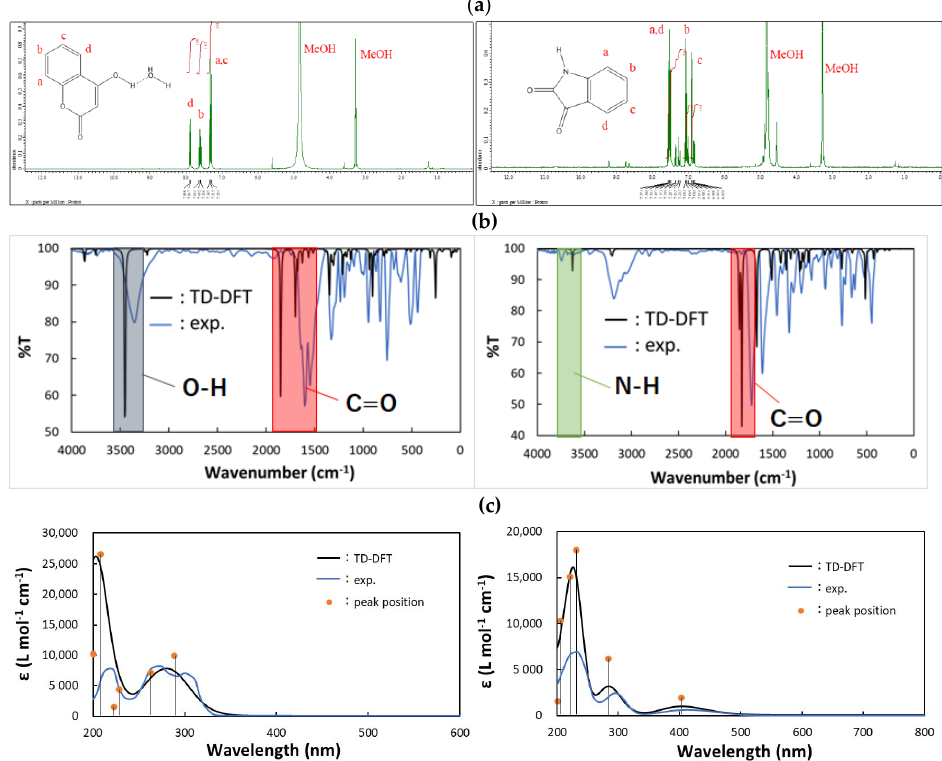
Figure 2. Comparison with experimental and DFT computational results of ( a ) NMR (only experimental) ( b ) IR and ( c ) UV-vis spectra for (left) CA1 and (right) CA4 . Both molecules adopted planar structures, with all the heavy atoms on one mean plane. As for CA1 , the six-membered carbon ring and heterocyclic moiety in the compound adopt a planar structure orientation, and are arranged in a parallel to slightly tilted position in the crystal. Significant hydrogen-bonding interactions of O1-H1A · · · O4 (O . . . O = 2.5578(13) Å), O4-H4A · · · O3 (cid:48) (O . . . O = 2.7659(15) Å), and O4-H4B · · · O3 (O . . . O = 2.7443(15) Å) are very much evident in the (Figure 3) (symmetry operation ‘: 1/2 − x, 1 − y, − 1/2 + z). As for CA4 , the six-membered carbon ring and heterocyclic moiety in the compound adopt a planar structure orientation, and is parallelly arranged in the crystal. Significant hydrogen bonding interactions of N1-H1 ⋯ O2 (O…O = 2.9017(14) Å ) are very much evident in the compound (Figure 4).